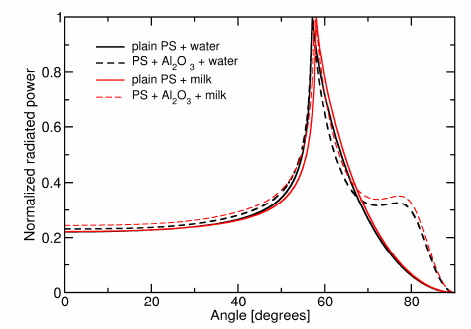
Fig. 1. Fluorescence distributions: the normalized radiated power as a function of the emission angle in the polystyrene substrate for water and milk with and without 5 nm Al 2 O 3 coating on the bottom of the fluid channel.